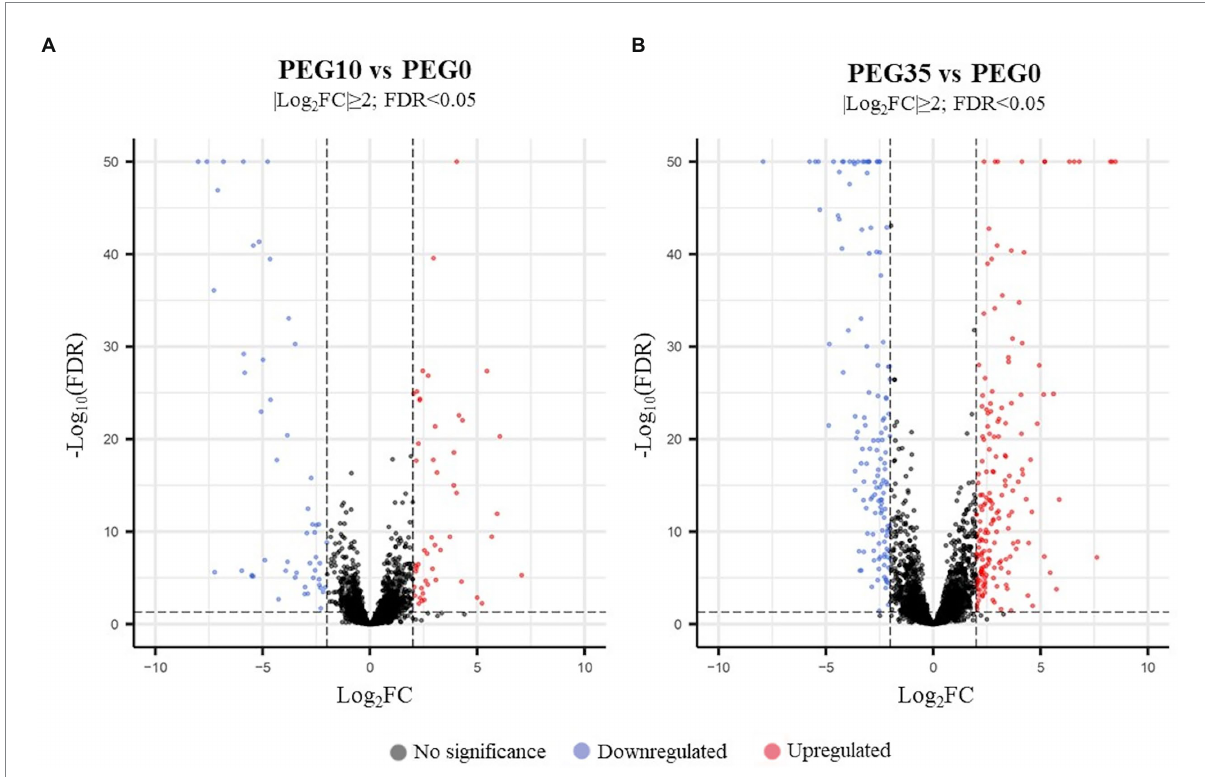
FIGURE 7 Volcano maps showing the distribution of DEGs according to their log 2 FC and -log 10 FDR. (A) DEGs found in PEG10 condition compared to control condition PEG0. (B) DEGs found in PEG35 condition vs. the control condition PEG0. Gray spots represent genes with a non-significant expression change, while blue and red circles represent down regulated and up regulated genes, respectively. Genes are considered differentially expressed when |log 2 FC| ≥ 2 and FDR <